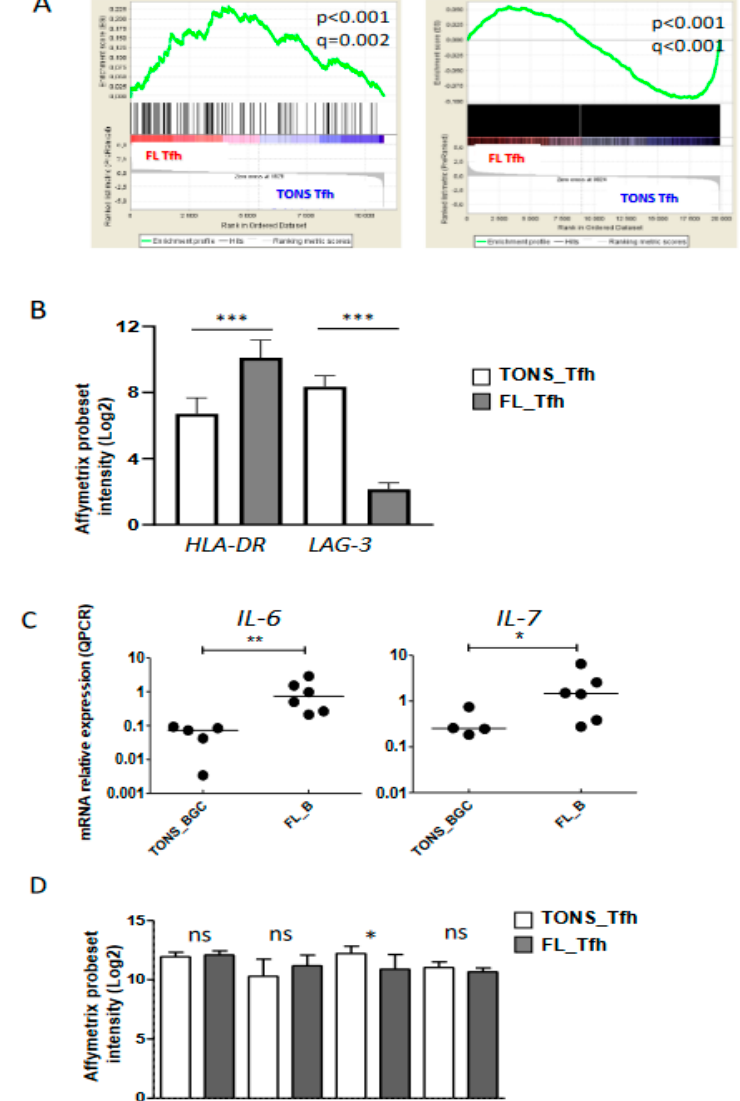
Figure 4. Tfh activation in FL tumor. ( A ) Plots from GSEA (gene-set enrichment analysis) analyses comparing Tfh from FL (FL Tfh) or TONS (non-malignant tonsils; TONS Tfh) based on an activated T signature (M3319 MSigDB geneset in left panel and activated Tfh signature obtained by Tfh stimulation with anti-CD3 / CD28 mAbs (see method) in right panel). Nominal p -value ( p ), and FDR (q) are given on the plot. FL Tfh are given on the left (red) of the plot and normal TONS_Tfh on the right (blue). ( B ) HLA-DR and LAG-3 mRNA expression on FL_Tfh or TONS_Tfh. ( C ) IL-6 (left panel) and IL-7 (right panel) mRNA expression by qRT-PCR in B lymphocytes isolated from reactive tonsils (TONS_BGC) ( n = 5) or FL tumors (FL_B) ( n = 6). The arbitrary value of 1 was assigned to a pool of five whole tonsil cells. ( D ) Gene expression of IL-6R and IL-7 subunits in normal Tfh (TONS_Tfh) or derived from FL (FL_Tfh). Bars: mean. ns non-significant, * p < 0.05, ** p < 0.01, *** p < 0.001.